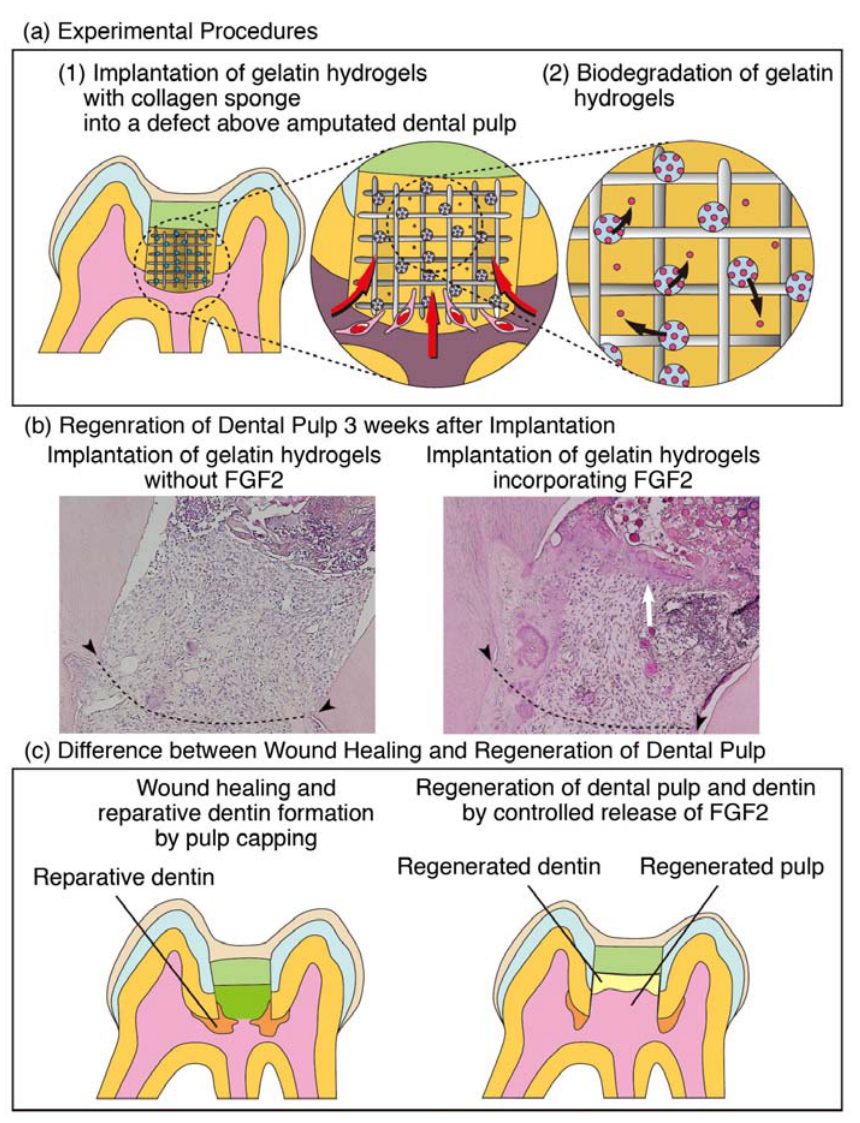
Figure 6. ( a ) Experimental procedures; ( b ) Regeneration of dental pulp and dentin by controlled release of FGF2 from gelatin hydrogels. Regenerative Dentin (arrow) on the surface of regenerated pulp was observed. Arrowhead and dotted line; amputated line of dental pulp; ( c ) Difference between wound healing and reparative dentin formation by pulp capping and regeneration of dental pulp and dentin by controlled release of